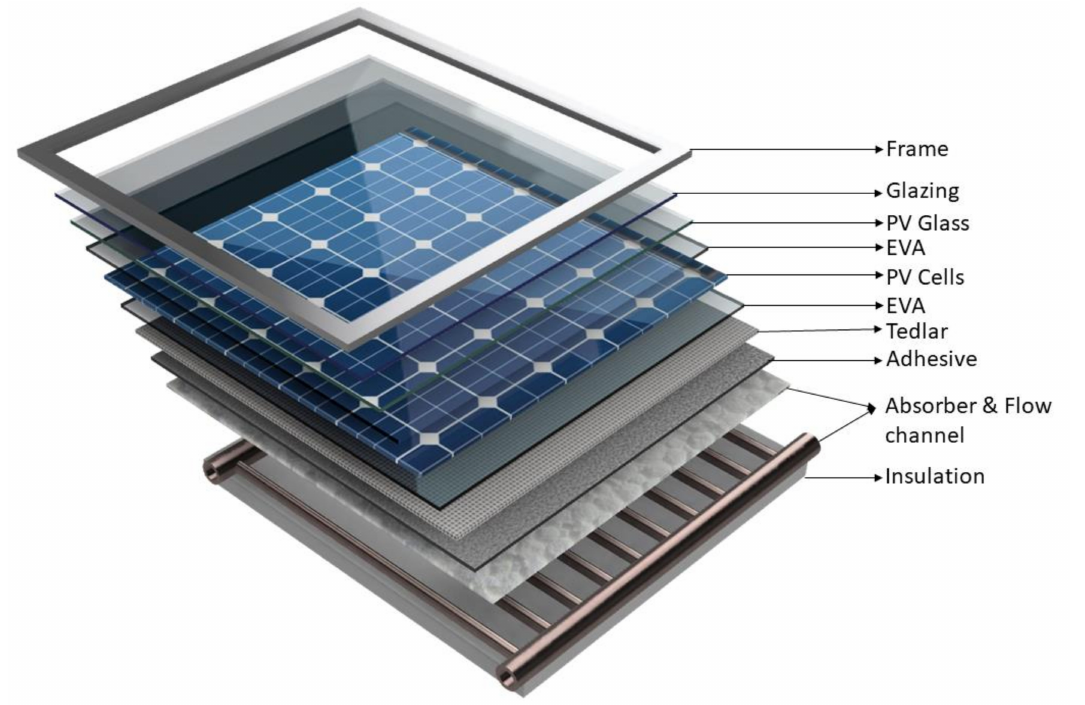
Figure 7. Detailed parts of typical water-based PVT